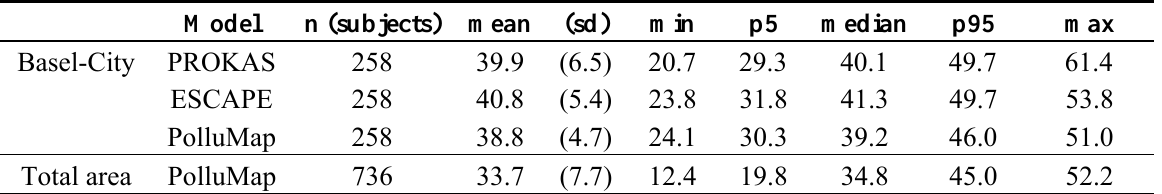
Table 3. Summary of time-weighted subjects’ NO for Basel-City by air pollution model, and for the total area (only one model